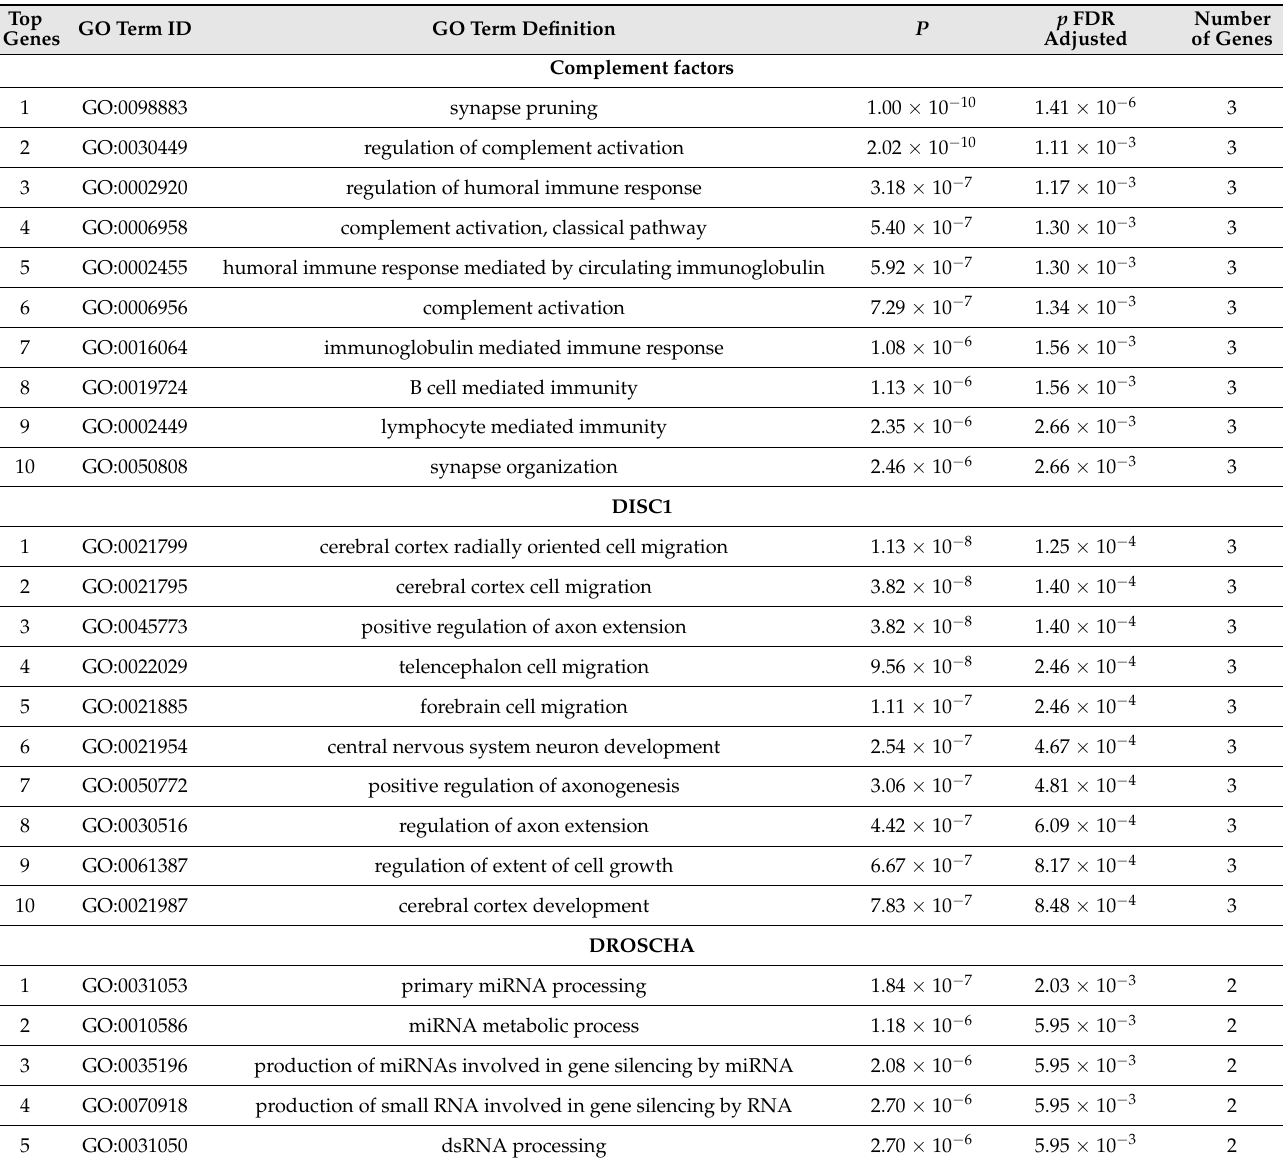
Table 2. Biological GO term classifications of differently expressed proteins in first episode psychosis or